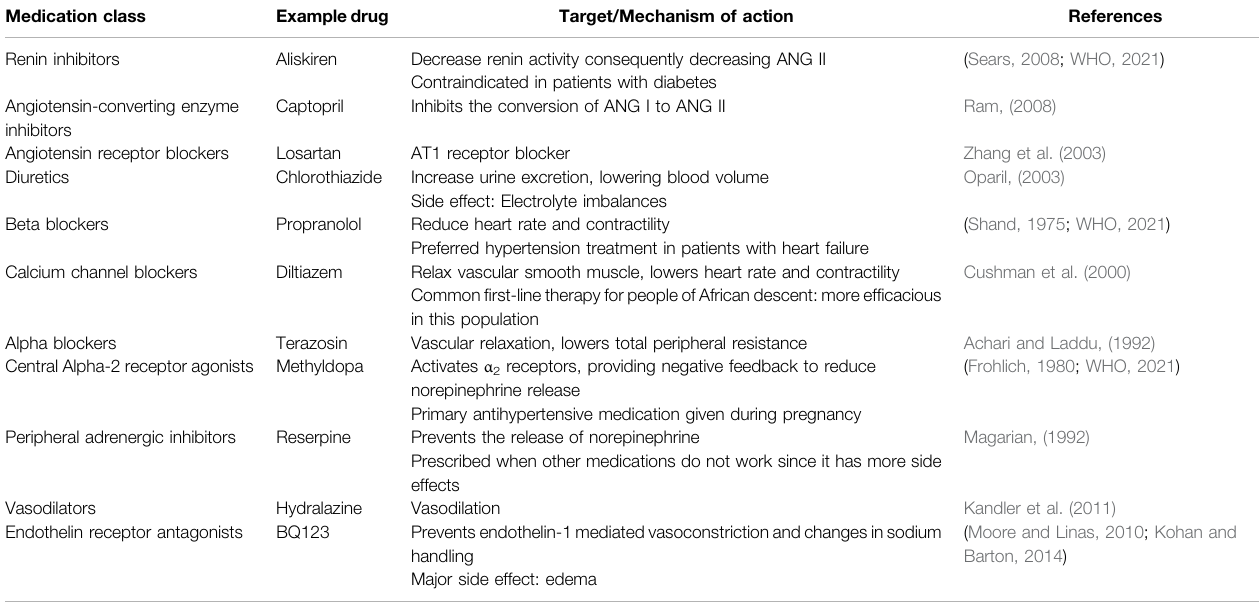
Table 1 ANG I — angiotensin I; ANG II — angiotensin